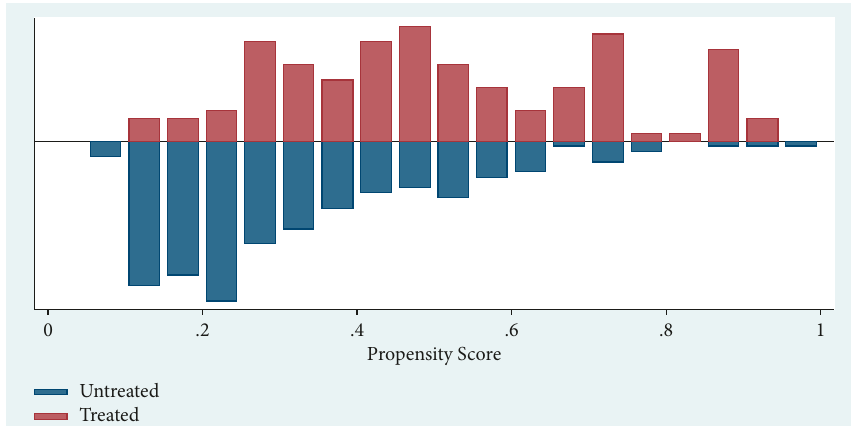
Figure 2: Propensity score distribution and common support region between the treated and untreated. Table 6: Testing of covariate balance using the propensity score (evaluation of quality of